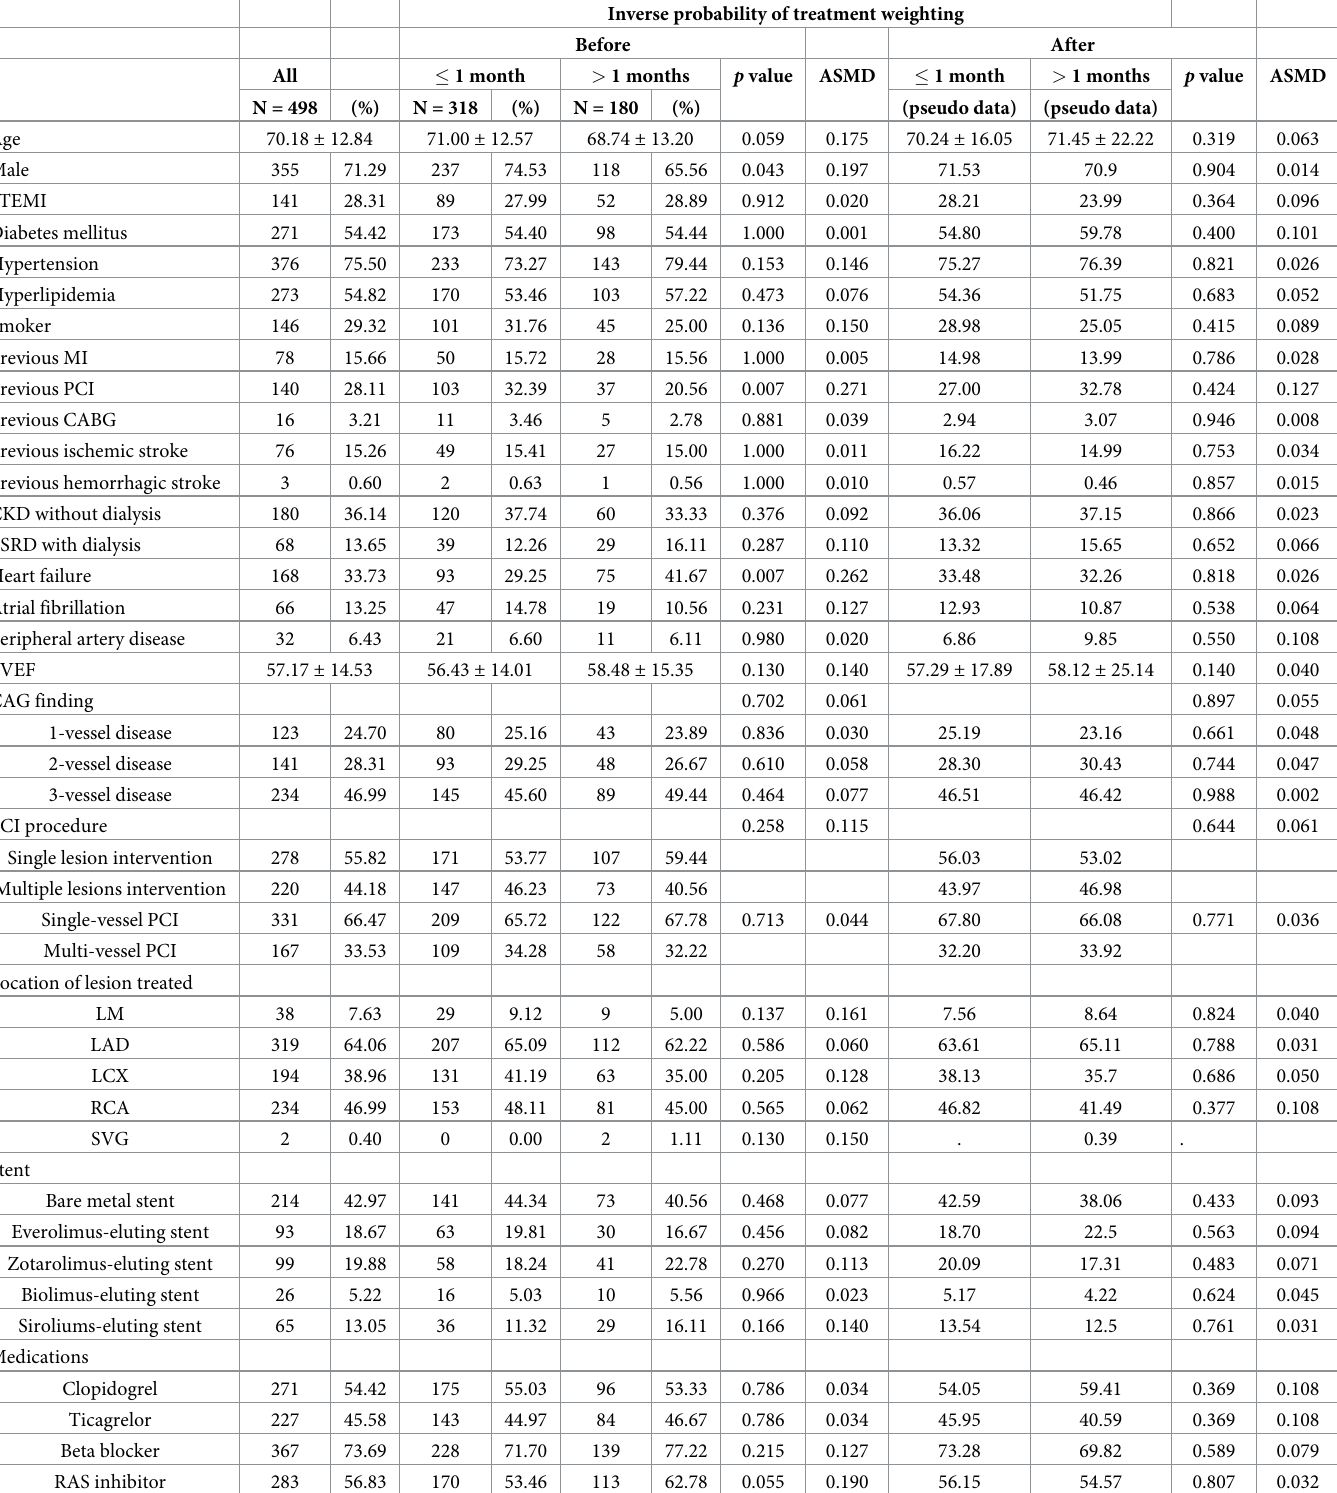
Table 1. Baseline characteristics of patients with different duration of aspirin use. Inverse probability of treatment weighting Before After All � 1 month > 1